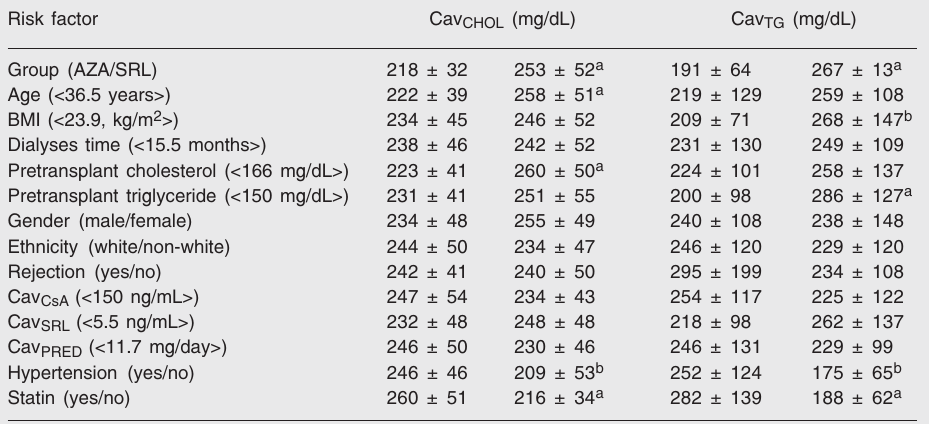
Table 4. Mean cholesterol (Cav CHOL ) and triglyceride (Cav TG ) according to risk factors during the first 12 months after transplantation. Risk factor Cav CHOL